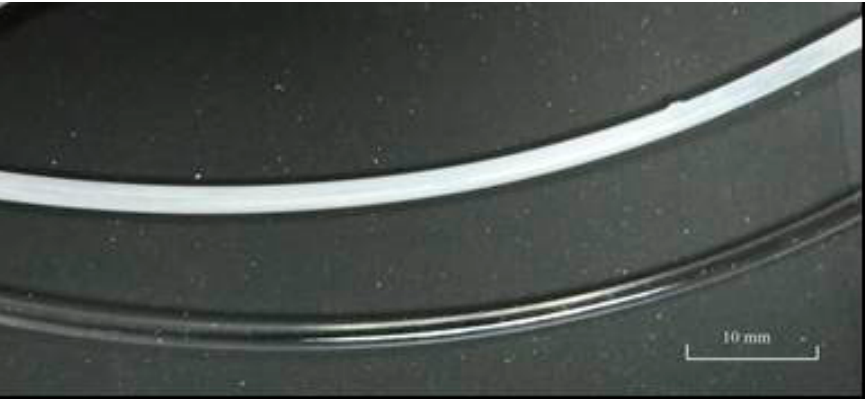
Figure 1. The appearance of PETG polyester sample before and during sorption of acetic ester. The sorption of ethyl acetate in the vapor phase at 20 ◦ C is shown in Figure 2a. The sorption maximum in the vapor phase is lower by 12–14% than in the liquid phase for all the polyesters studied. An increase in temperature from 20 ◦ C to 40 ◦ C leads to an increase in the maximum extent sorption for PETG by 14%, for PET by 1%, and for PCTG by 3%.